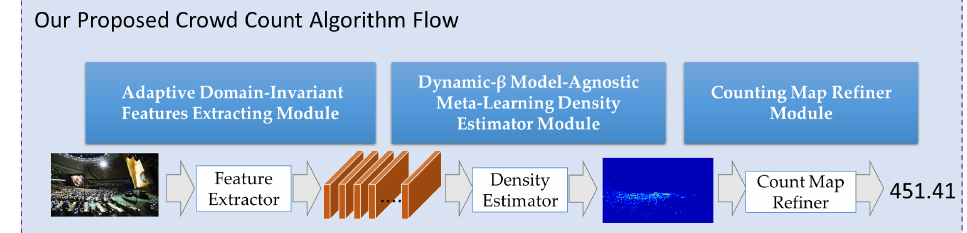
Figure 1. Comparison of the main proposed algorithm flow with general crowd-counting algorithm flow. The three modules proposed to enhance model generalization capability: Adaptive Domain- Invariant Features Extracting module, Dynamic- β Model-Agnostic Meta-Learning Density Estimator Module, and Counting Map Refiner